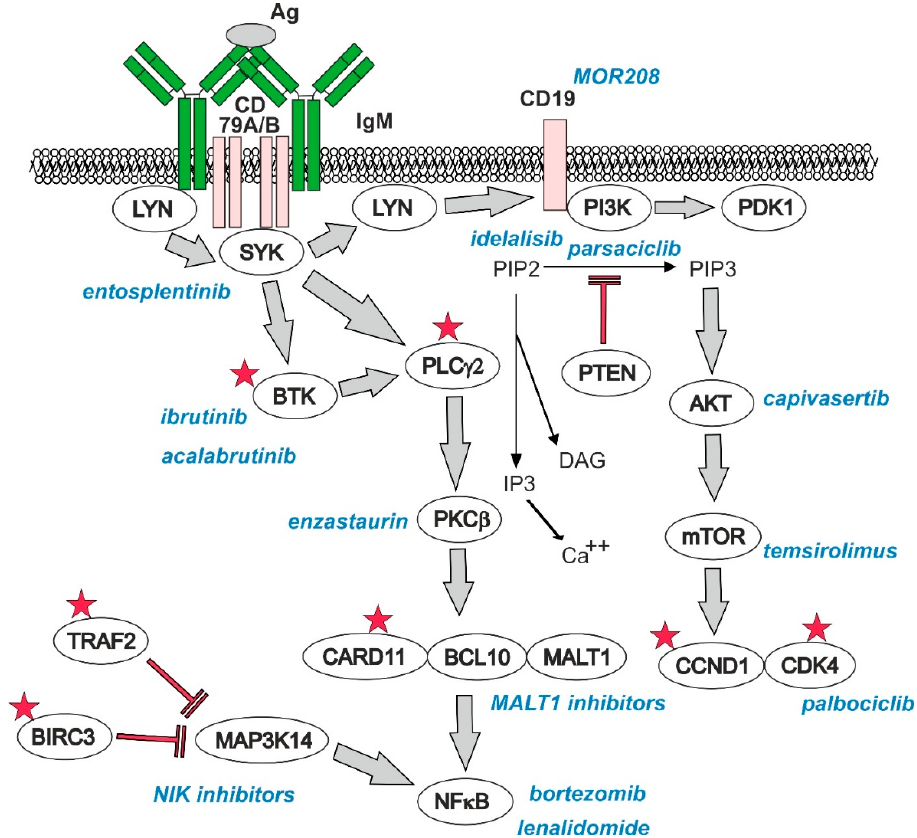
Figure 3. BCR signaling in MCL (asterisks indicate recurrently mutated genes in MCL; PIP2 = Phosphatidylinositol (4,5)-bisphosphate; PIP3 = phosphatidylinositol (3,4,5)-trisphosphate; DAG = diacylglycerole; PDK1 = phosphoinositide-dependent kinase 1) .